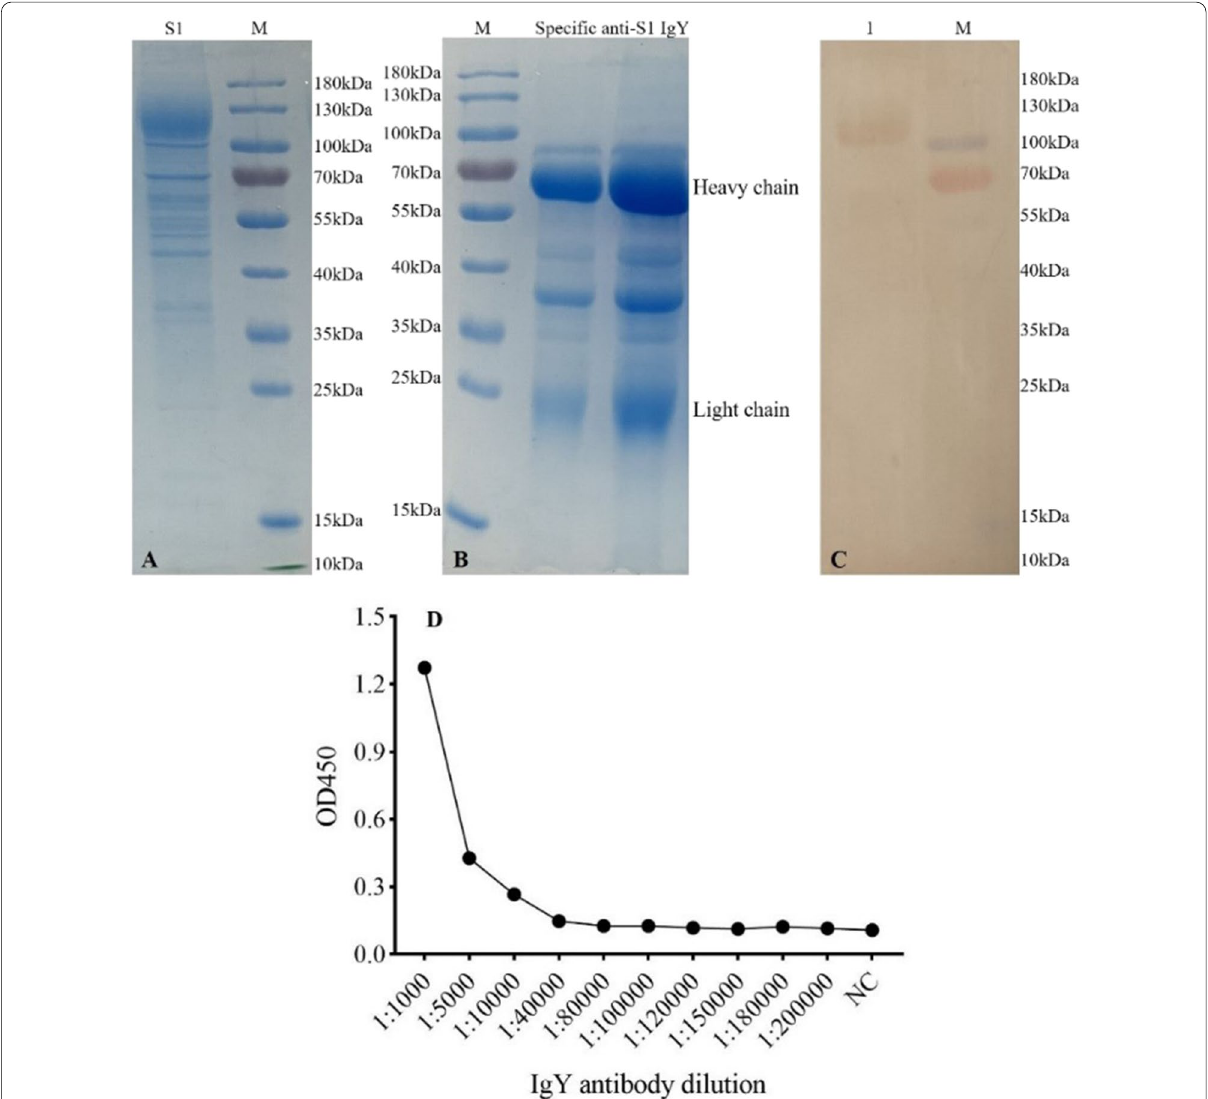
Fig. 1 Characteristics of the S1proteien and specific anti-S1 IgY antibody. A SDS-PAGE analysis of the S1proteien. B SDS-PAGE analysis of the specific anti-S1 IgY antibody. C Western blot analysis of the specific IgY antibody. Lane 1, antigen was S1 protein, incubated with primary antibody IgY. D the analysis of the specific IgY antibody titer; Negative control sample (NC): PBS; Statistical principle, P/N > 2.0 (P, samples value; N, NC value), results are means of three replicates. M, Pre-stained Protein Ladder (Thermo Fisher Scientific, Waltham, MA, USA). The secondary antibody, goat anti-chicken IgY H&L (HRP) (Abcam, Cambridge,